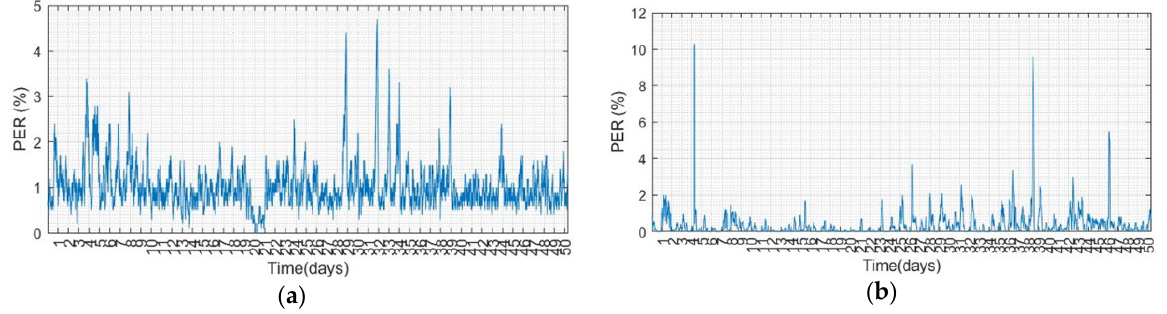
Figure 12. PER in 1000-window of moving average for ( a ) Node 5 and ( b ) Node 6.